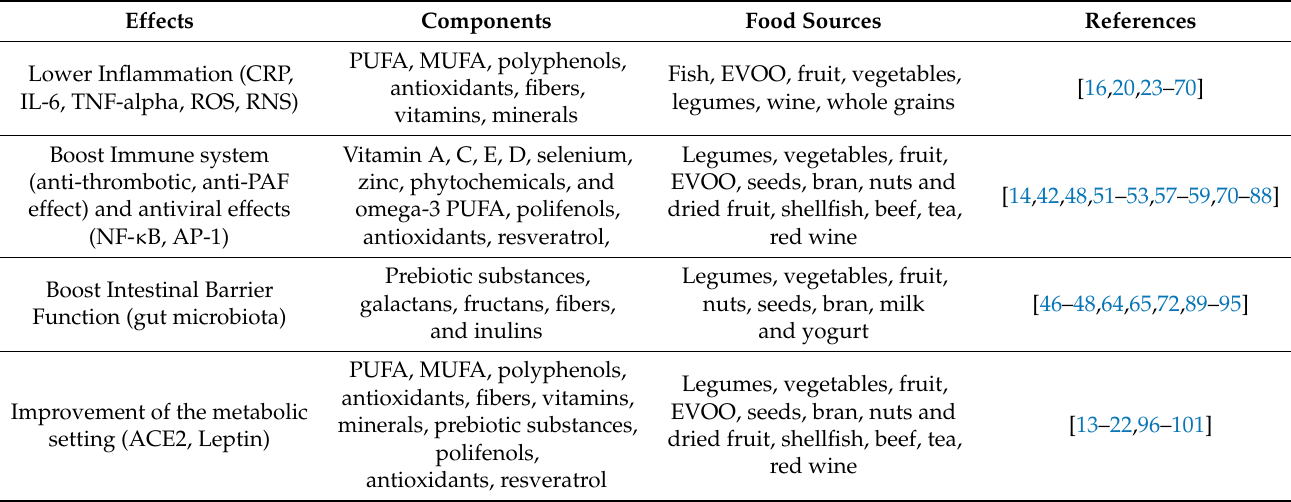
Table 1. Possible anti-SARS-CoV-2 effects attributed to